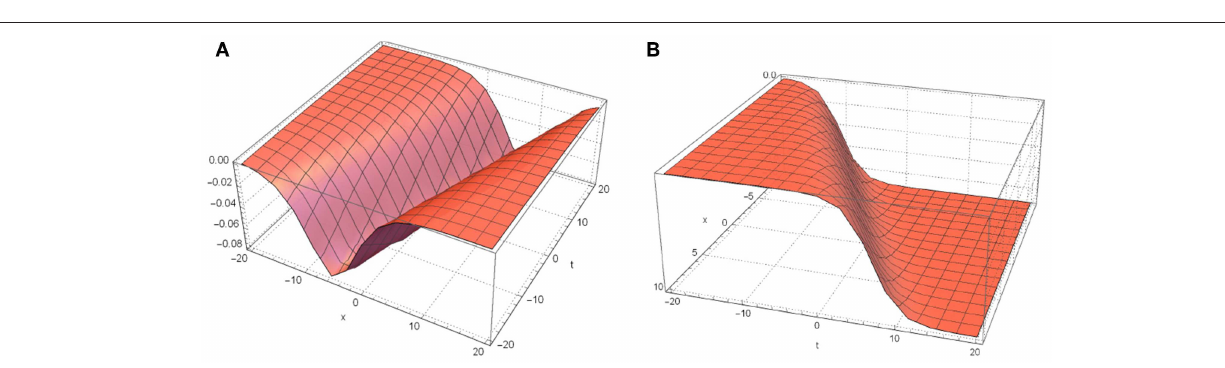
FIGURE 2 | Dynamic behavior of u 5 ( x , t ), u 8 ( x , t ) for k 2